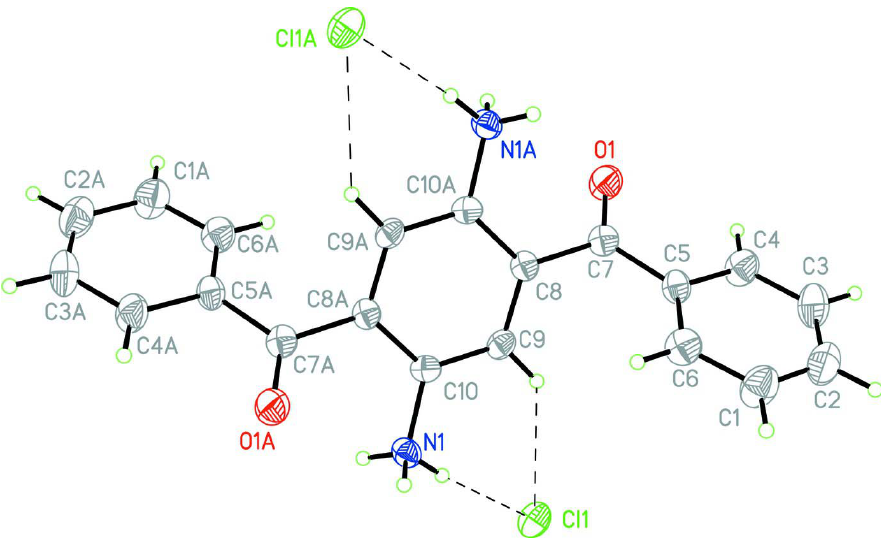
Figure 1 The molecular structure of the title compound, showing 40% probability displacement ellipsoids. Atoms labelled with the suffix a are generated by the symmetry operations (1 - x , 1 - y , - z ). Hydrogen bonds are shown as dashed